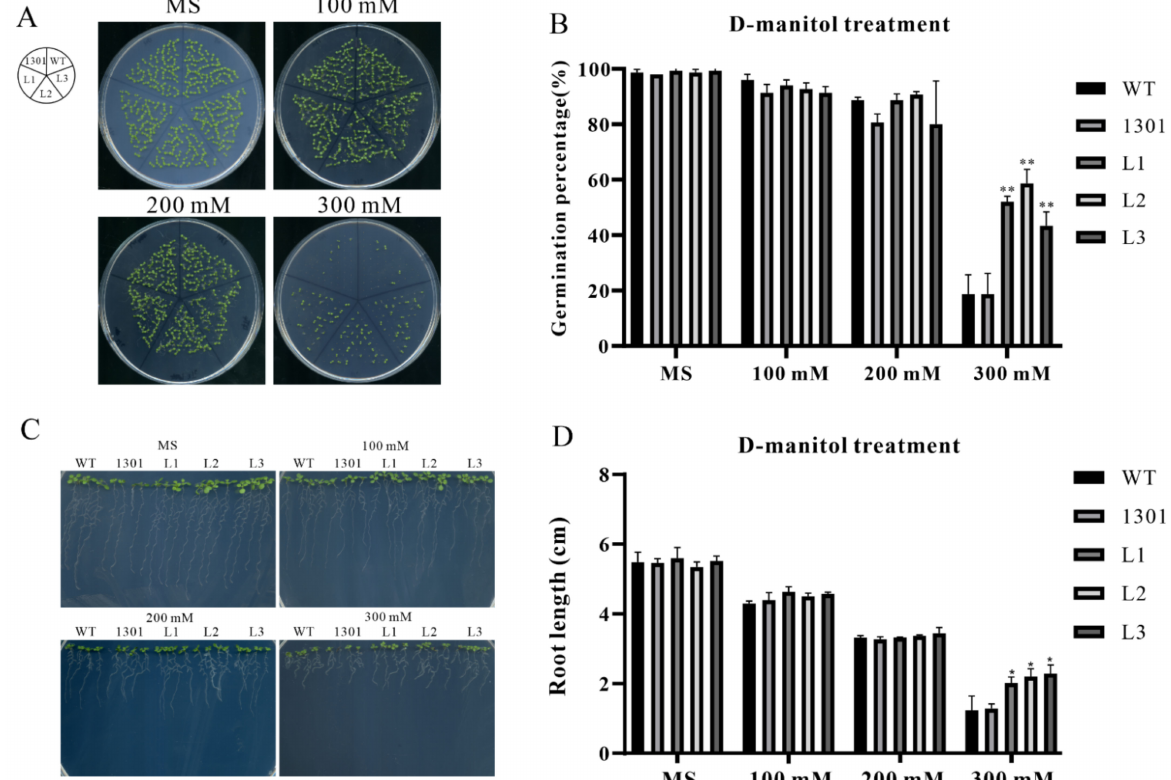
Figure 12. Germination assay and root length analysis of ZmSAP8 transgenic Arabidopsis after manni- tol treatment. Values are presented as the mean ± standard error of values from three independent experiments. ( A ) Comparison of germination percentage between transgenic (L1-L2-L3), the trans- genic vector-only control (1301), and wild-type (WT) plants. ( B ) Germination statistics of transgenic (L1-L2-L3), 1301, and WT plants ( C ) Comparison of root lengths between transgenic (L1-L2-L3), 1301 and WT plants. ( D ) Root length statistics of transgenic (L1-L2-L3), 1301, and WT plants. Asterisks indicate significant differences compared to the value for WT and 1301 (Student’s t -test; * p < 0.05; ** p <